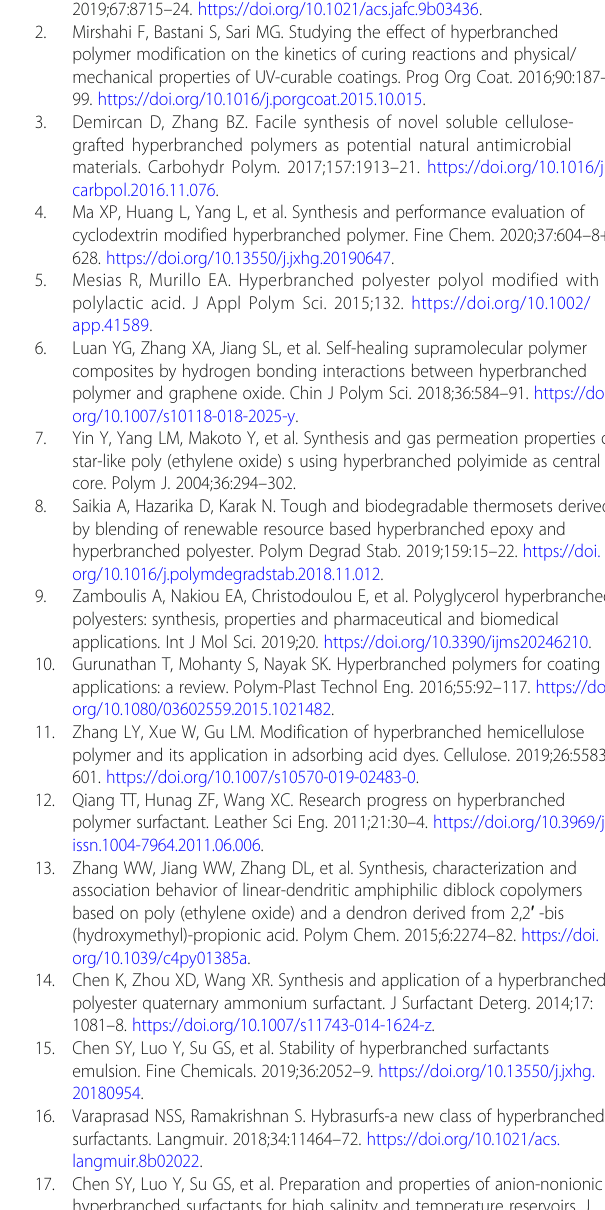
Additional file 1: Fig. S1. The influence of reaction temperature on product grafting rate. Fig. S2. The influence of solvent dosage on product grafting